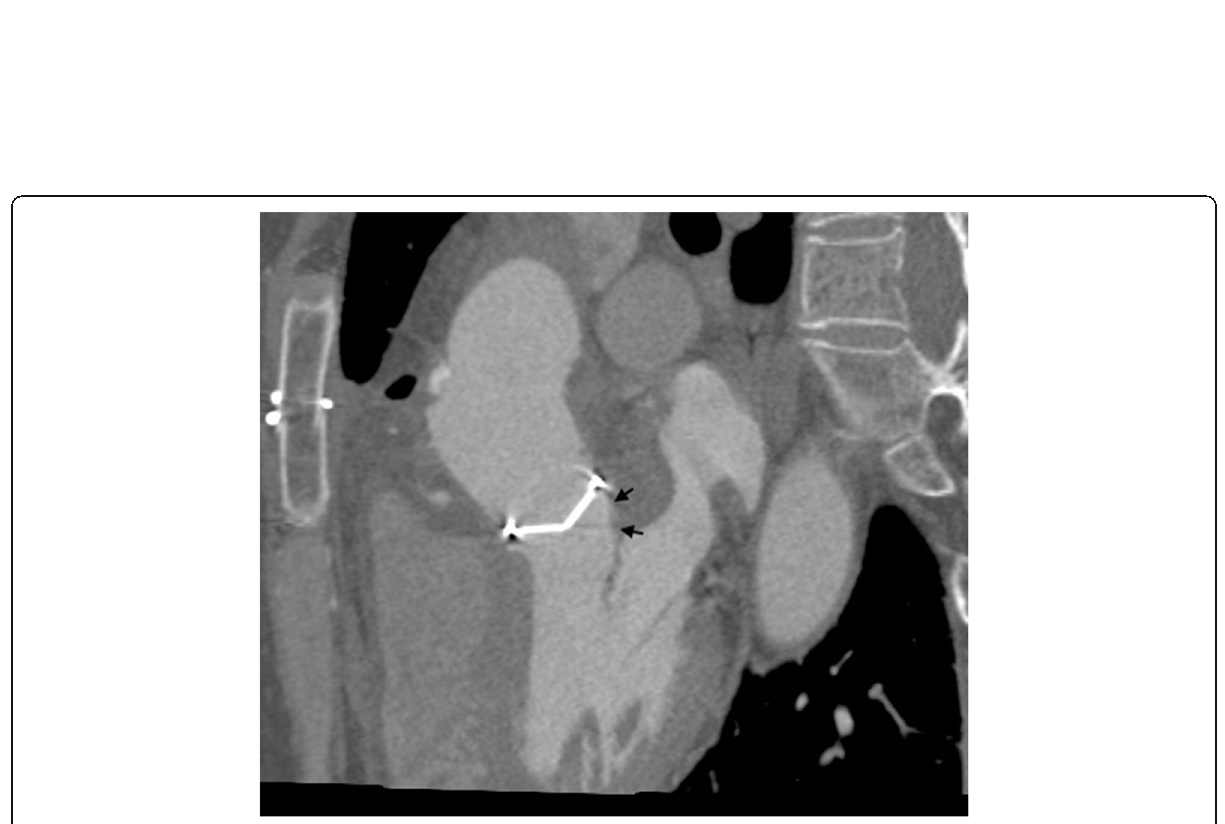
Fig. 3 Post-operative computed tomography. The closed entry (arrows) of the pseudoaneurysm of the mitral-aortic intervalvular fibrosa is